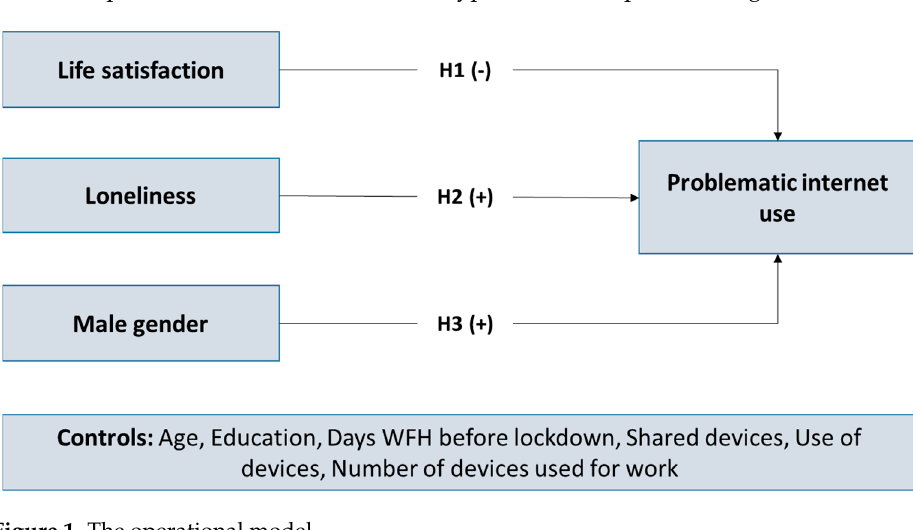
Figure 1. The operational model.